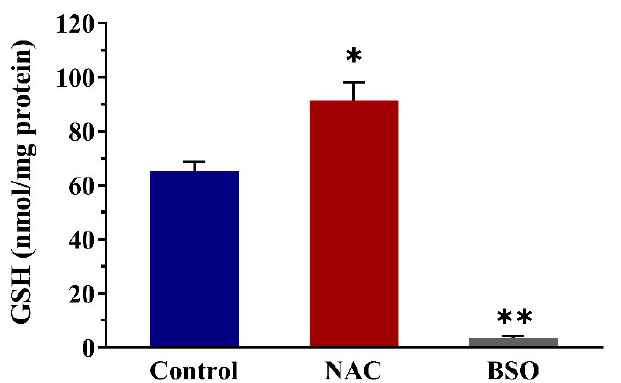
Figure 8. Changes in intracellular GSH levels after exposure of Nrf2 CALUX cells to NAC or BSO only. Data are shown as mean ± SEM of three independent replicates. * p < 0.05 and ** p < 0.01 compared with the solvent control. NAC: N-acetyl-L-cysteine, BSO: L-buthionine-sulfoximine.